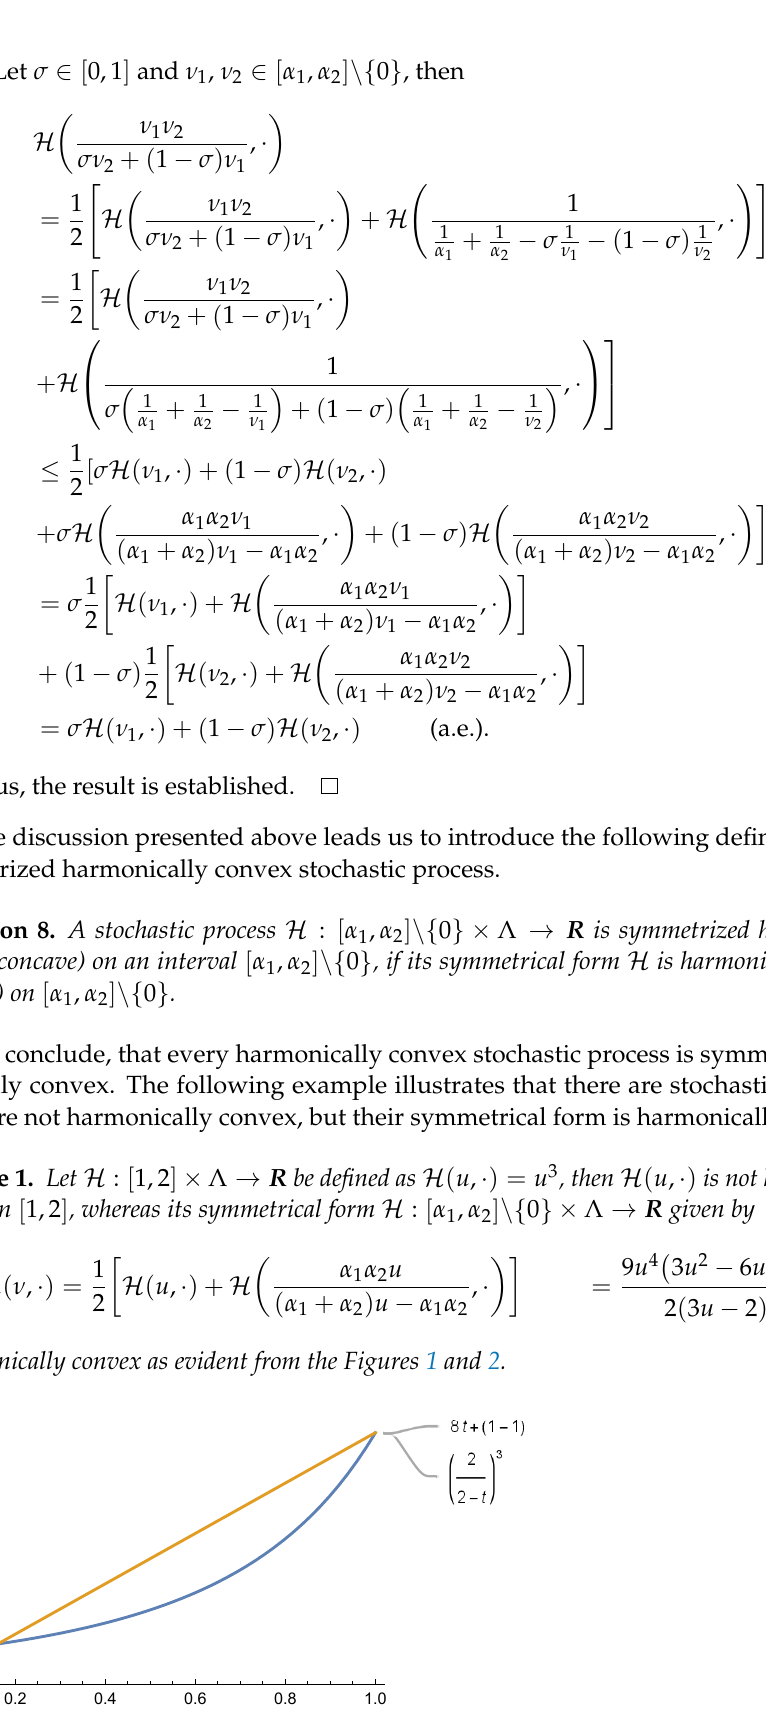
Figure 1. The graph shows that X ( u , · ) = u 3 is not harmonically convex on [ 1,2 ]